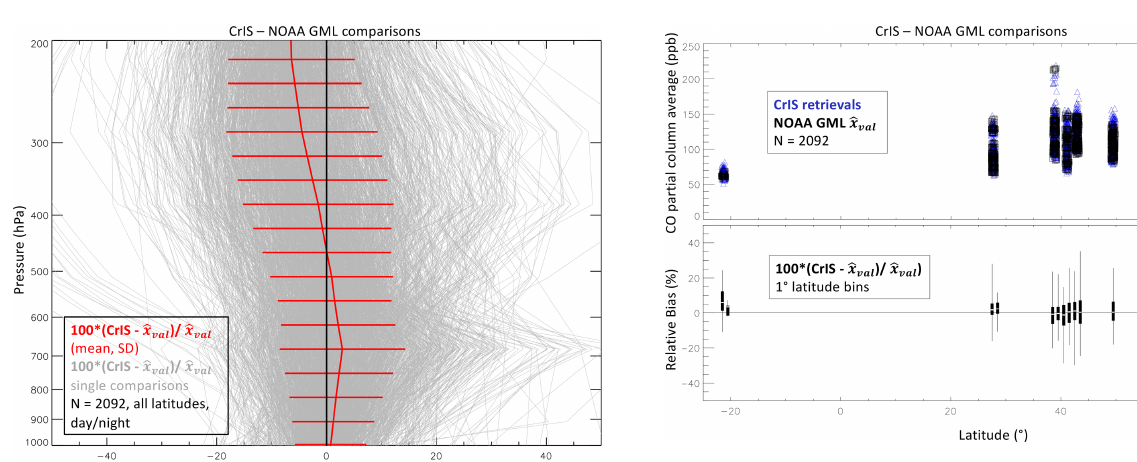
Figure 5. Latitude dependence of CO partial column average VMR (ppb) for TROPESS/CrIS retrievals and NOAA GML ˆ x val (a) as well as bias difference statistics (b) shown by box–whisker symbols representing minimum and maximum values (whisker), lower quar- tile (box bottom), median (white stripe), and upper quartile (box top). A minimum of five comparisons per bin was